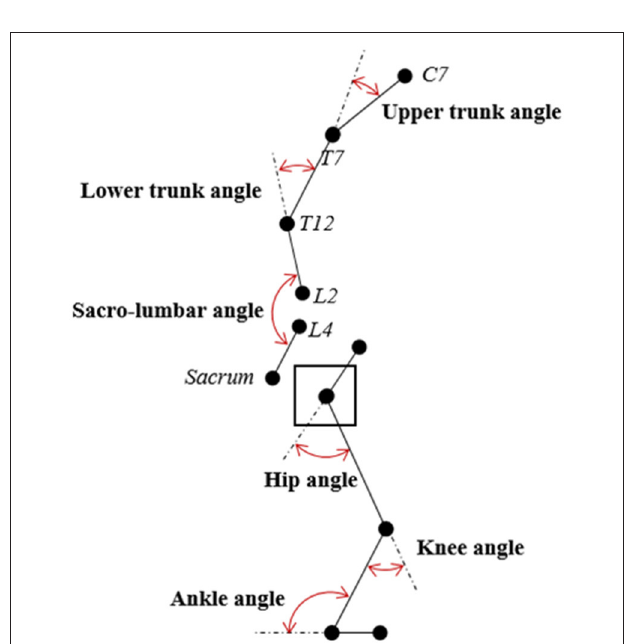
FIGURE 2 | Schematic representation of the body